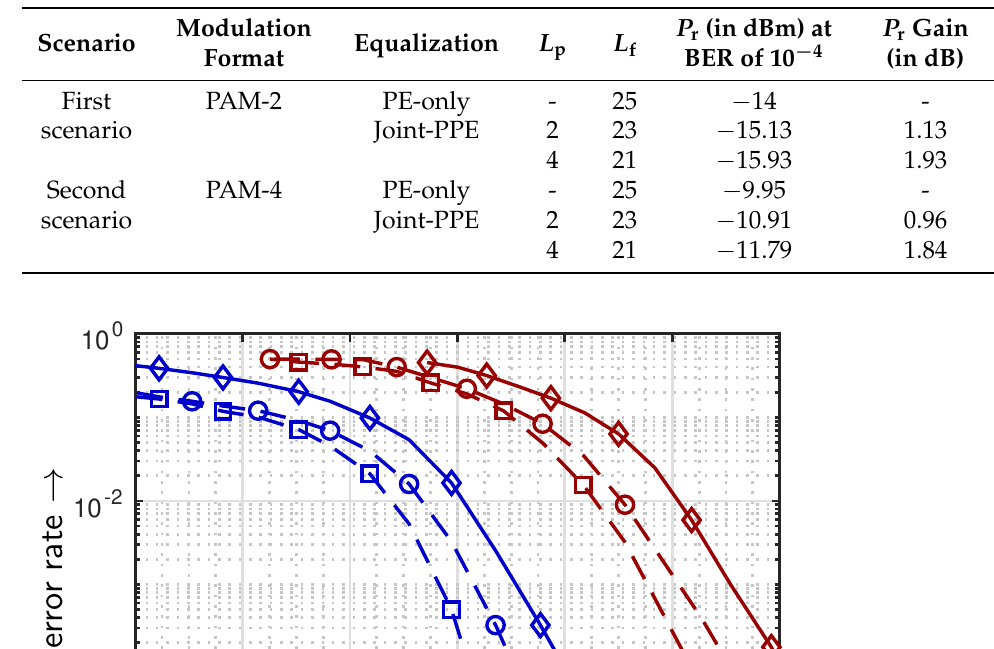
2 ) optical MIMO system at 10 − 4 BER ×